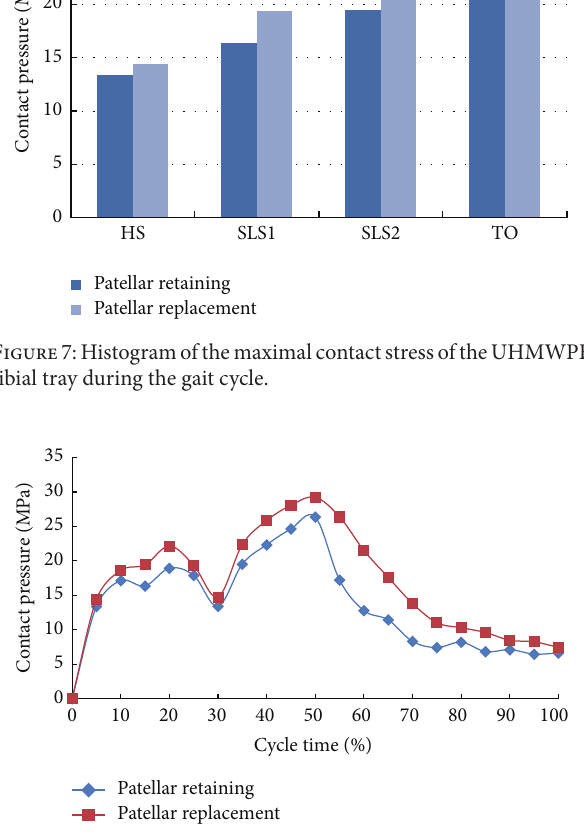
Figure8:Variationinthepeakcontactstressofthetibialtrayduring the gait cycle for the patellar retaining versus patellar replacement TKA